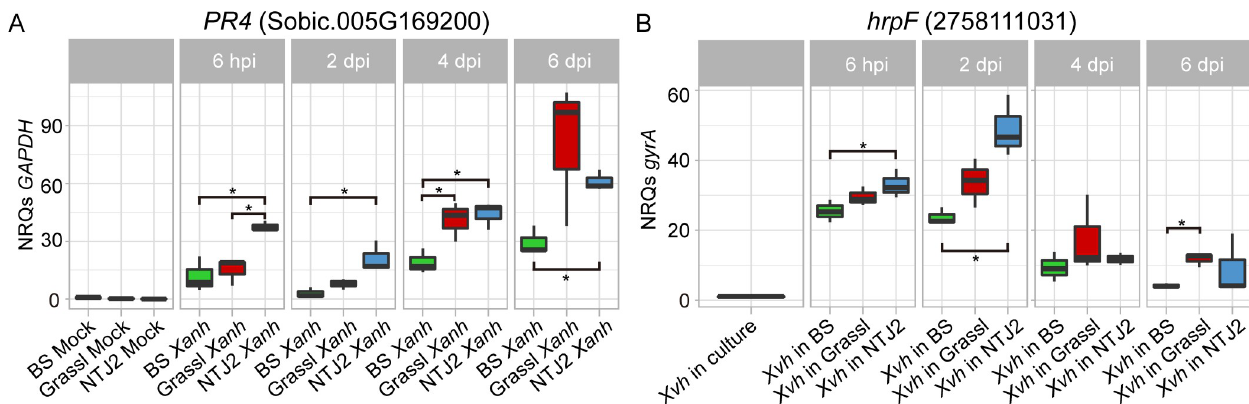
Fig 10. Time course of gene expression of sorghum PR4 and Xvh hrpF . qRT-PCR analysis of sorghum PR4 (A) and Xvh hrpF (B). PR4 and hrpF levels are reported as normalized relative quantities (NRQs) relative to sorghum GAPDH and Xvh gryrA , respectively. Mean ± s.d.; n = 3 biological replicates. Each plant-mock or plant- Xvh replicate contained three inoculation areas from three leaves from three individual plants. Xvh inoculum level was OD 600nm = 0.5 (~1 × 10 9 cfu/mL). Each Xvh in culture replicate contained ~1 × 10 8 bacterial cells. Asterisks indicate statistical significance based on unequal variances t test (n = 3, � p < 0.05) of pairwise comparisons. BS (water-soaked lesions), Grassl (red lesions), and NTJ2 (resistance).